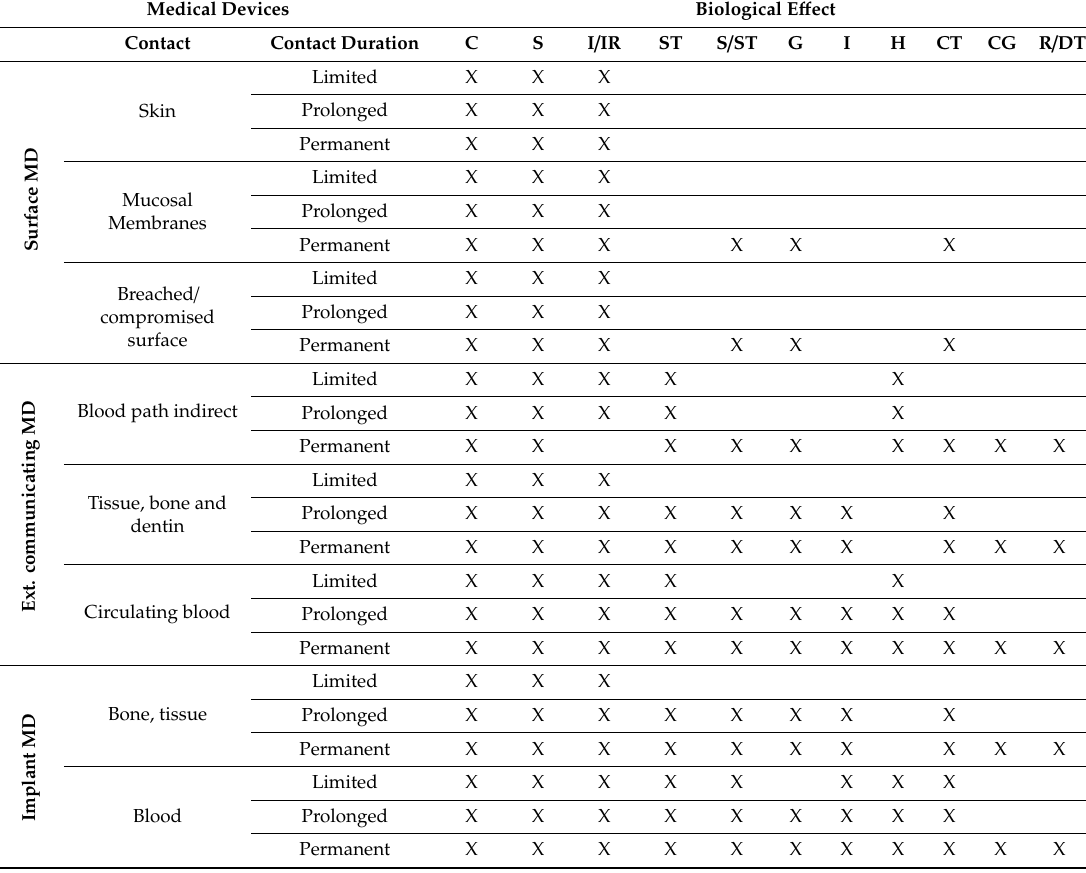
Table 4. Biological evaluation test of MDs (C: cytotoxicity; S: Sensitization; I / IR: Irritation / intracutaneous reactivity; S / ST: Systemic toxicity; G: Genotoxicity; I: Implantation; H: Hemocompatibility; CT: Chronic toxicity; CG: carcinogenicity; R / DT: Reproductive / developmental